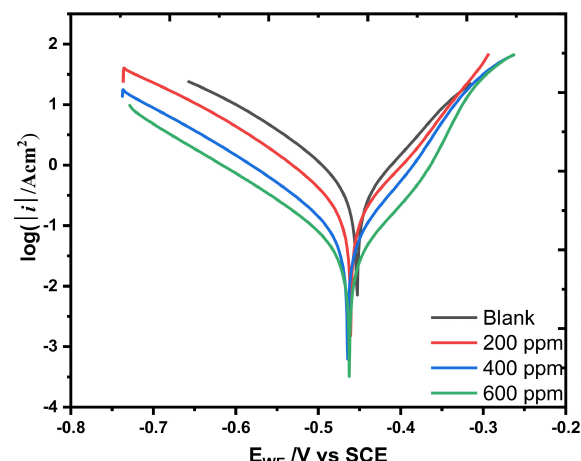
Figure 8. Tafel plots of mild steel in 1 M HCl at di ff erent concentrations of PBSLP at a scan rate of 1.0 mV /